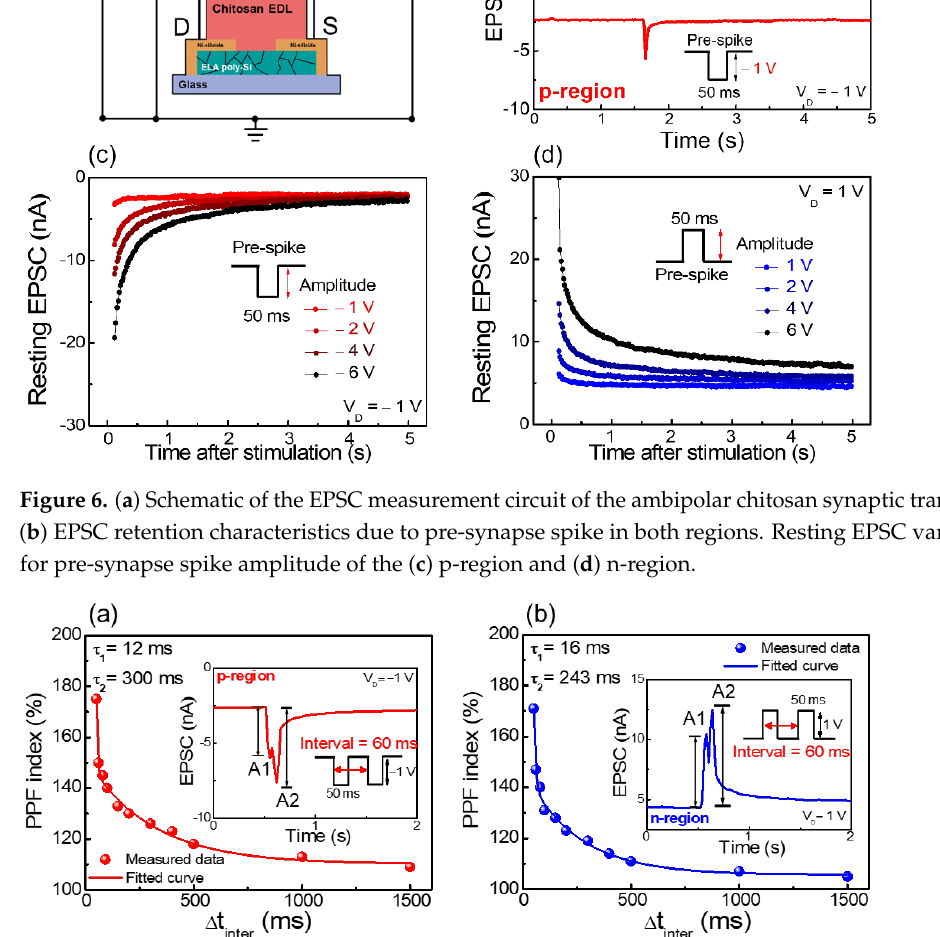
Figure 7. Paired-pulse facilitation (PPF) index (defined as A2/A1 × 100%) of the ( a ) p-region and ( b ) n-region. The solid line represents the fitting curve of the double-phase exponential function. Inset: EPSC triggered by a paired spike with a 60 ms interval.